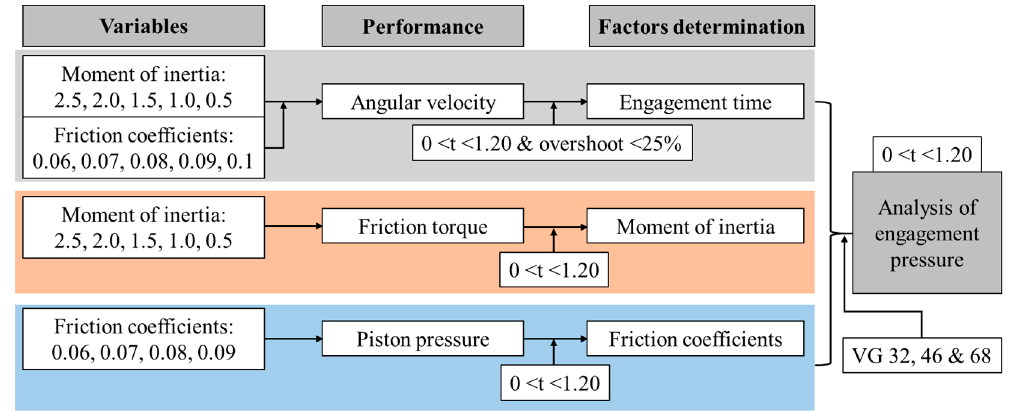
Figure 7. The overall procedure of this study.